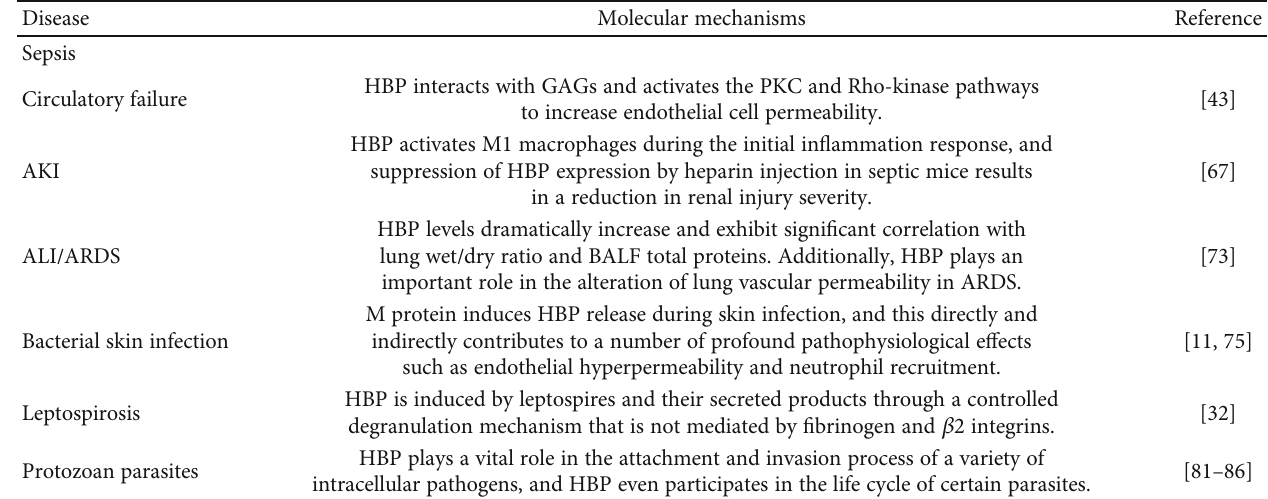
Table 1: The molecular mechanisms of HBP in various diseases.